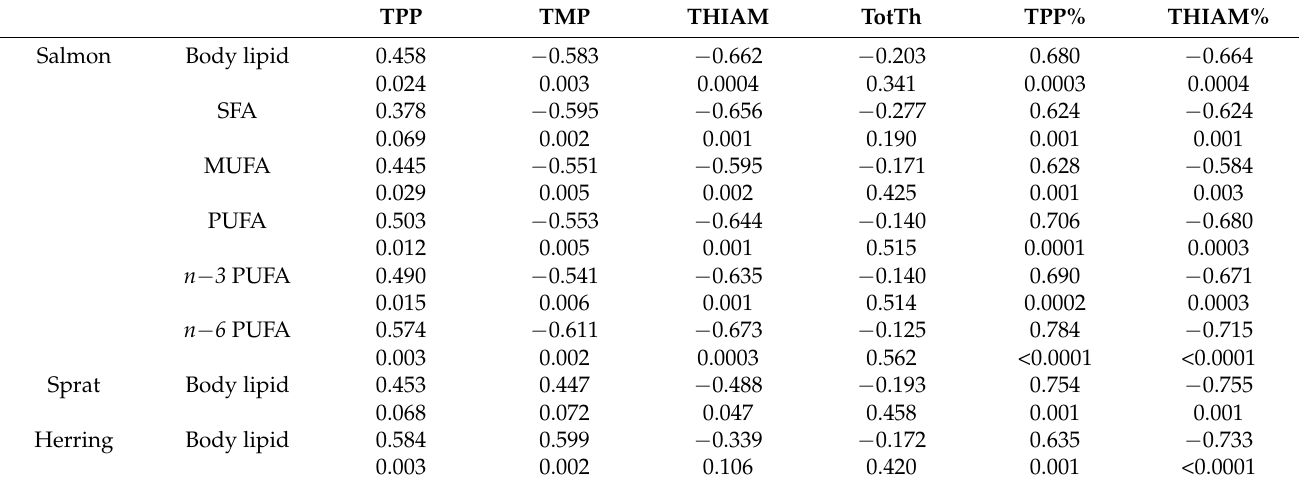
Table 3. Pearson correlations of the concentrations (nmol g − 1 ) of thiamine pyrophosphate (TPP), thiamine monophosphate (TMP), unphosphorylated or free thiamine (THIAM), and total thi- amine (ToTh), and the proportions of TPP and THIAM in salmon ( Salmo salar ) muscle and in sprat ( Sprattus sprattus ) and herring ( Clupea harengus ) with the lipid content (%) and the concentrations (i.e., lipid-weighed proportions, mg g − 1 ) of fatty acid classes of salmon. Salmon and prey fish caught in the three Baltic Sea areas: the Baltic Proper; the Bothnian Sea; and the Gulf of